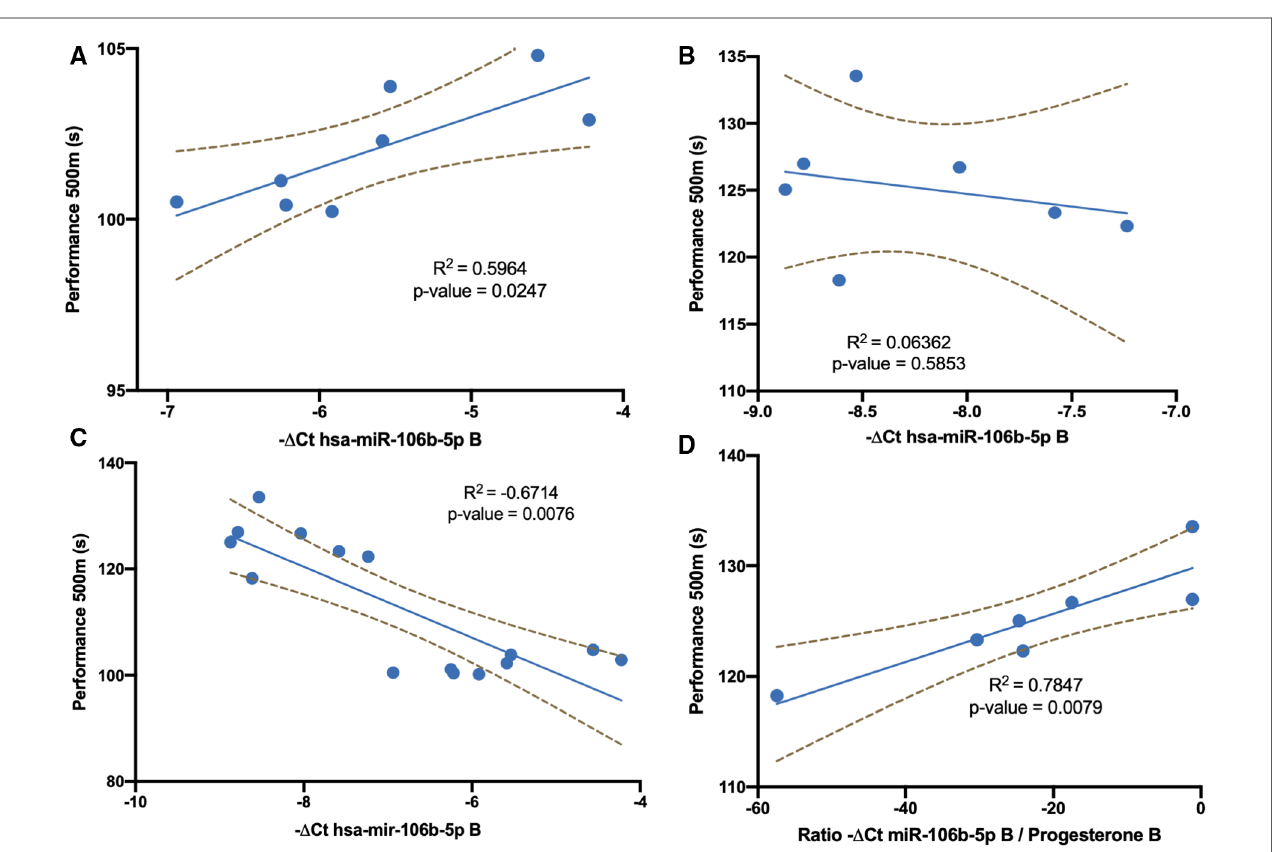
FIGURE 2 Linear regression analysis of exercise performance data. ( A ) Mir-106b-5p levels and exercise performance in men athletes at point B. ( B ) Mir-106b-5p levels and exercise performance in women athletes at point B. ( C ) Mir-106b-5p levels and exercise performance both in men and women athletes at point B. ( D ) Ratio of mir-106b-5p levels / progesterone and exercise performance in women athletes at point